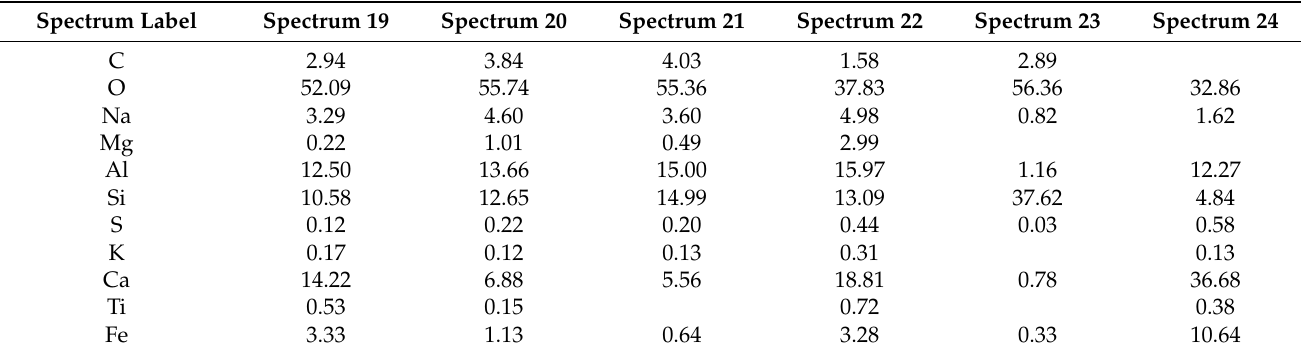
Table 7. Content of elements in analysed points, in